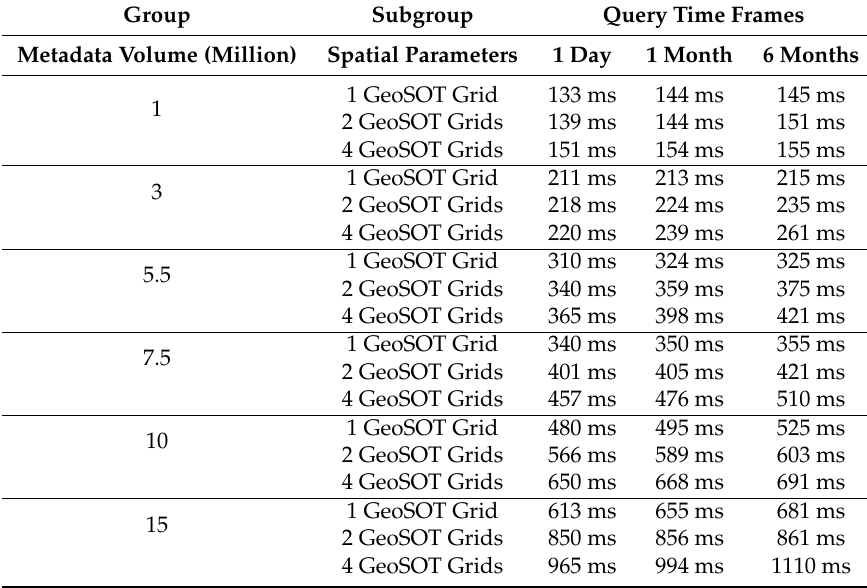
Table 6. The search conditions and time consumed of each